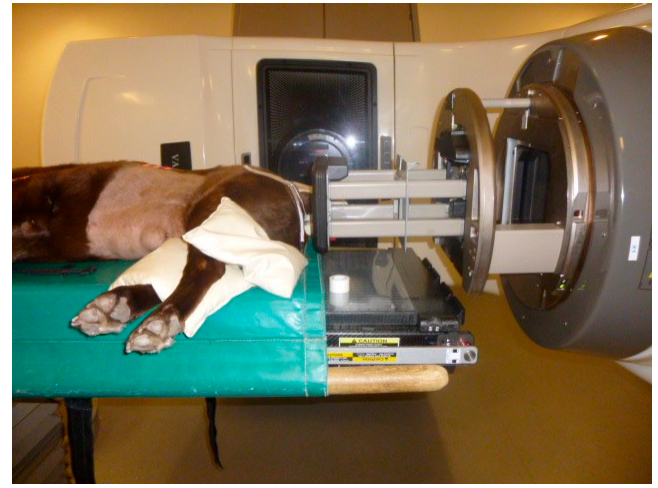
Figure 2. Position of the patient for the radiotherapy treatment.